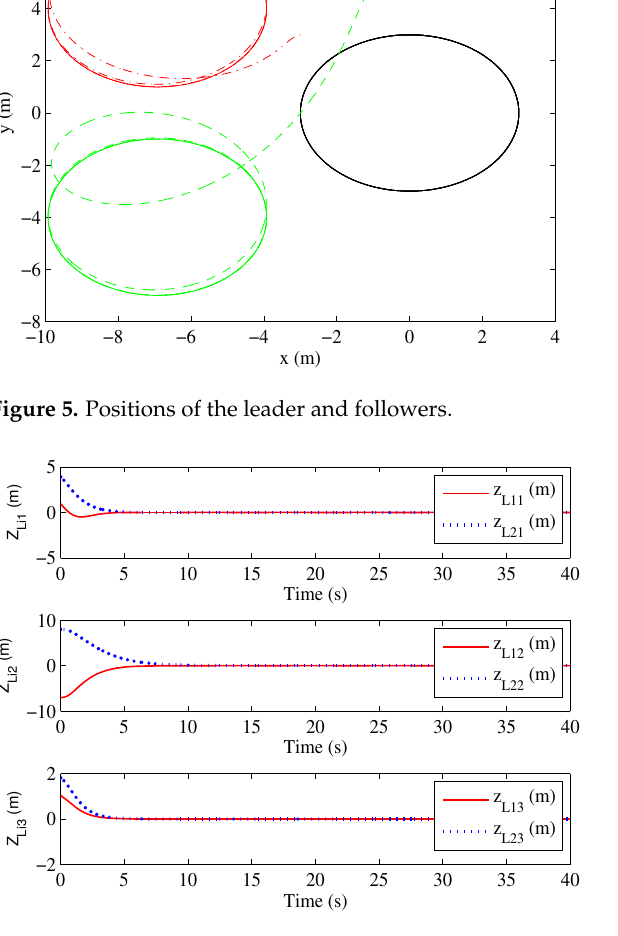
Figure 6. Generalized error of follower 1 and follower 2 with respect to the leader.